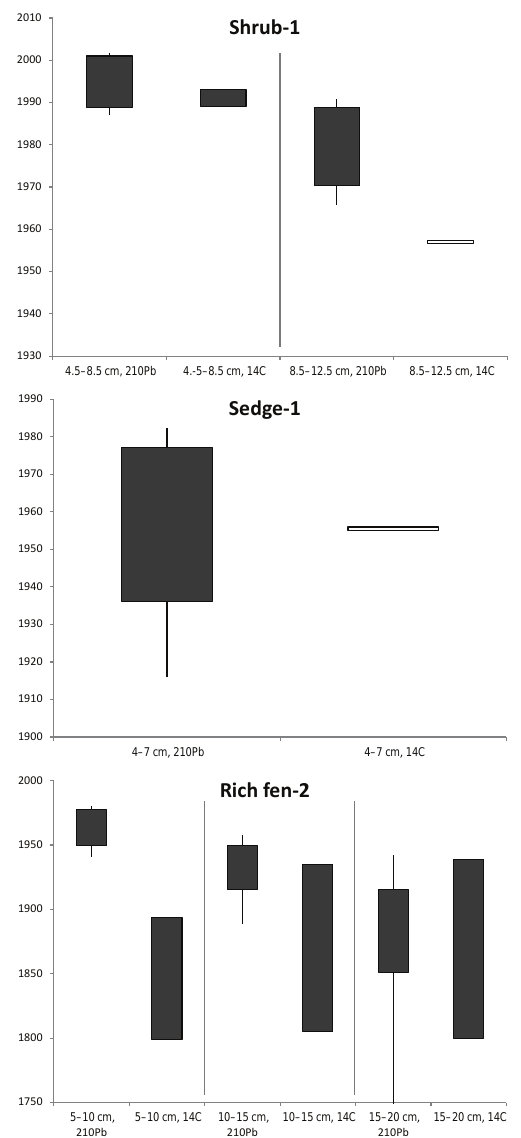
Figure 1. Comparison of 210 Pb and 14 C ages for depth increments where both analyses are available. The material dated for 14 C ages was deciduous leaf fragments (shrub samples), seeds (sedge sam- ple), or moss leaves and seeds (rich fen samples). The 210 Pb values listed include estimated